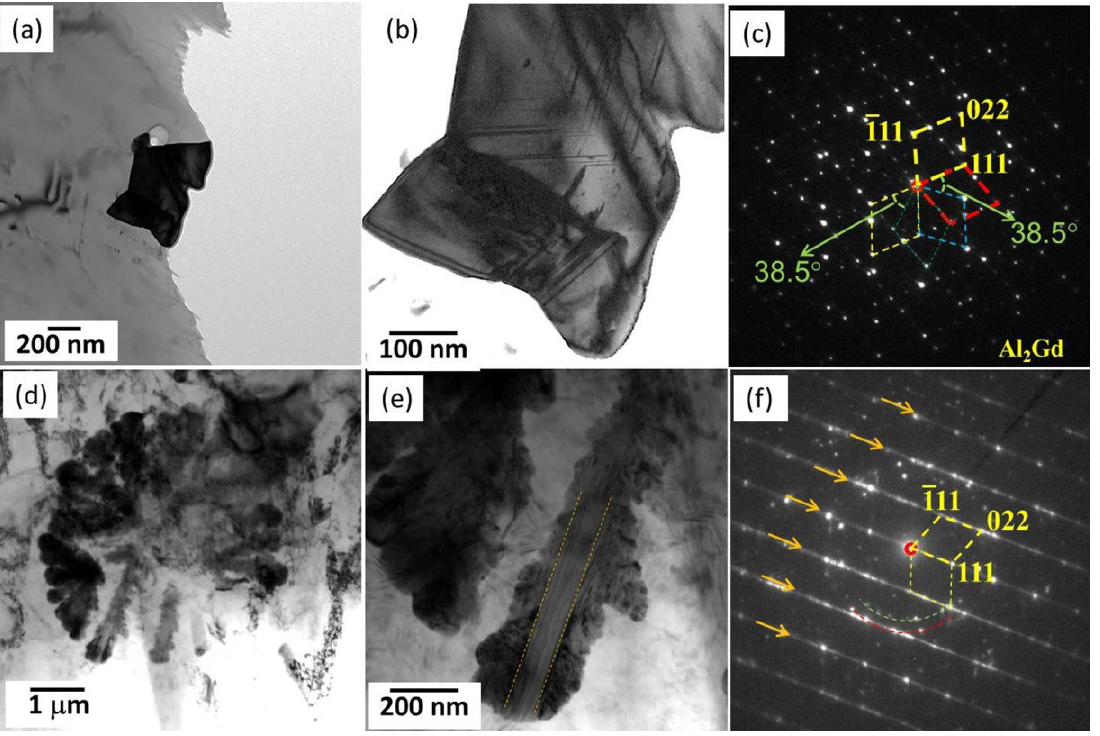
Figure 9. T EM images and the corresponding SAED paerns of Al 2 Gd in the AGd44 alloys